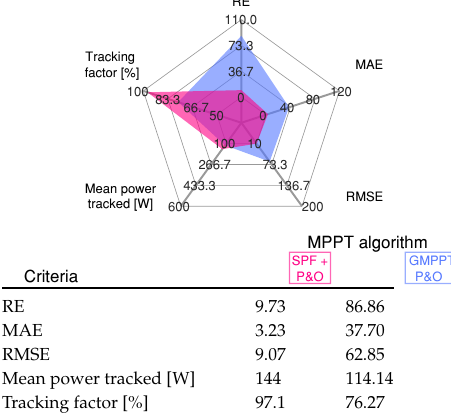
Figure 16. Comparative analysis of the MPPT methods for Scenario 6 shown in Figure